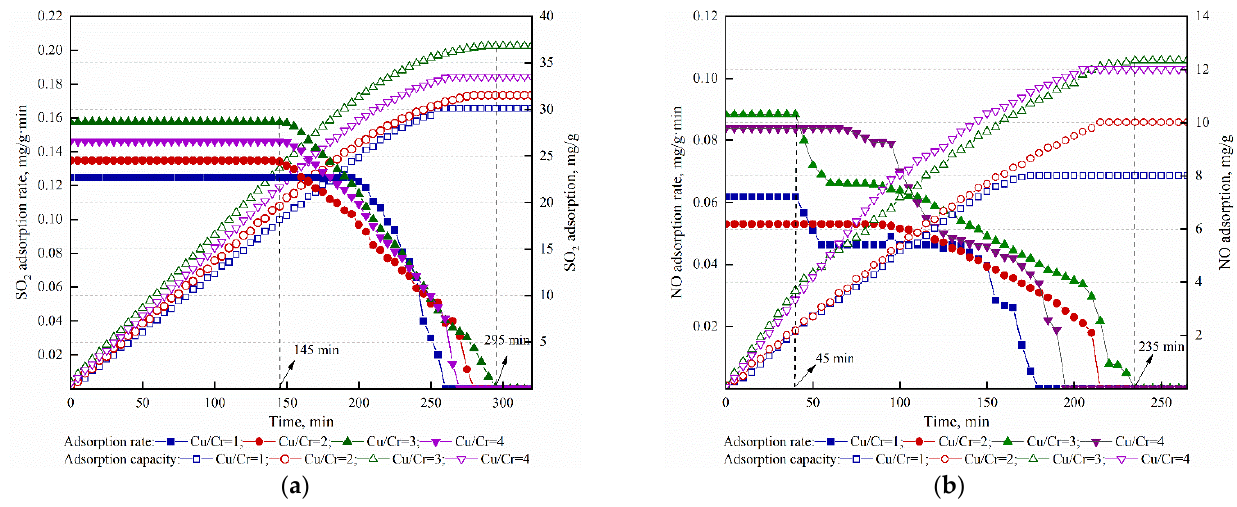
Figure 6. The effect of the doping ratio of Cu to Cr. ( a ) The adsorption of SO 2 ; ( b ) the adsorption of NO.